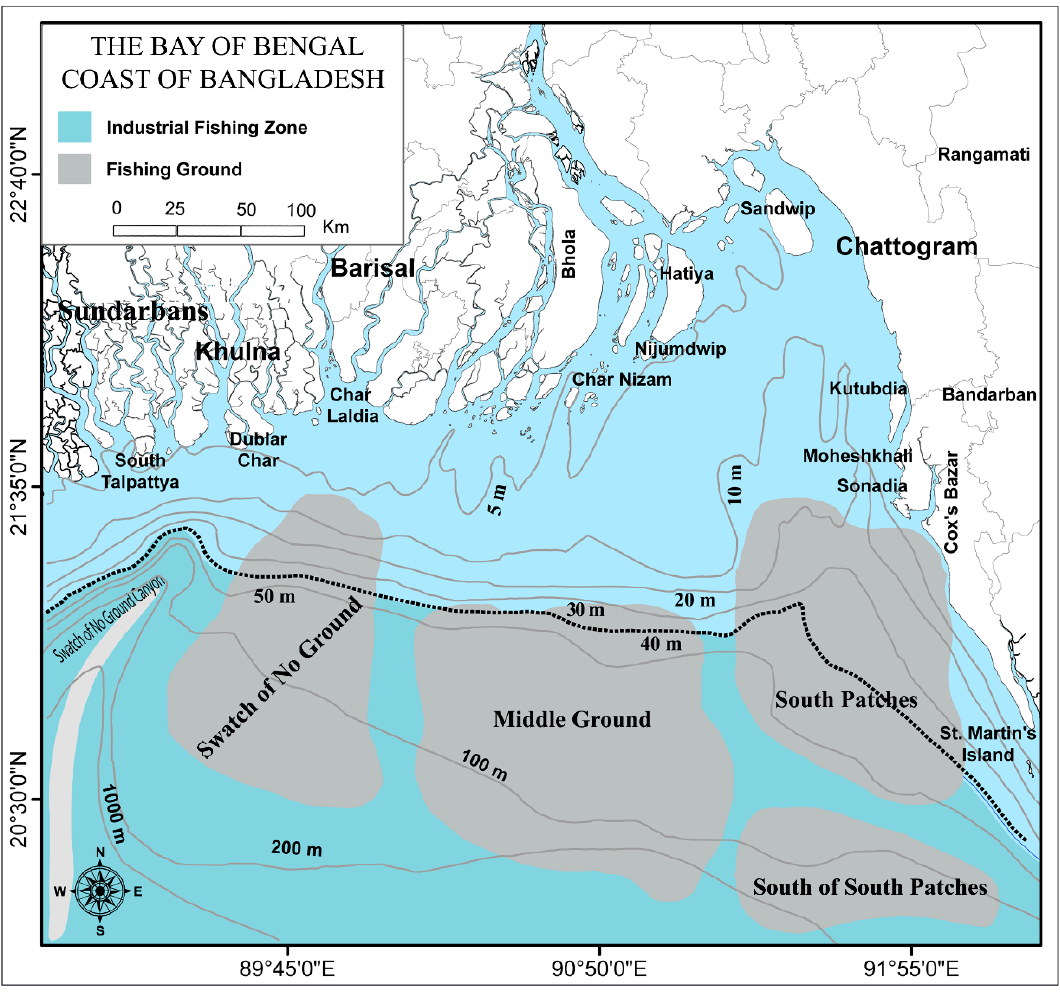
Figure 1. Map showing the Bay of Bengal coast of Bangladesh. The area beyond the black dotted line (40 m depth contour) is the industrial fishing zone. Shaded regions indicate the four major fishing grounds, i.e., South Patches, South of South Patches, Middle Ground, and Swatch of No Ground.